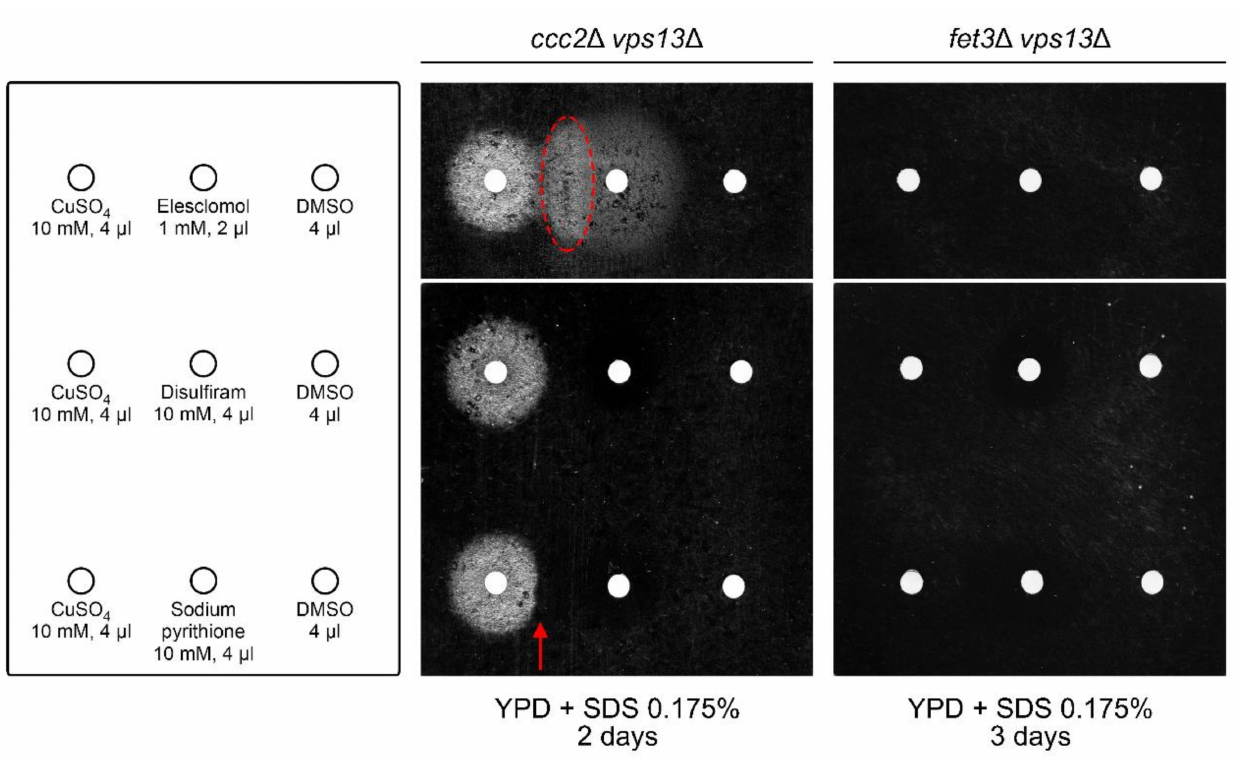
Figure 6. Impact of copper ionophores on the growth of ccc2 ∆ vps13 ∆ and fet3 ∆ vps13 ∆ cells on YPD + SDS media. Respective strains were spread onto the plates and substances were spotted on the filter papers. The order of the substances and concentrations used are indicated. DMSO was used as a negative control. The dashed ellipse in red indicates the enhanced zone of growth in the border between copper sulphate and elesclomol application. The red arrow indicates the zone of growth suppression in the border between copper sulphate and sodium pyrithione